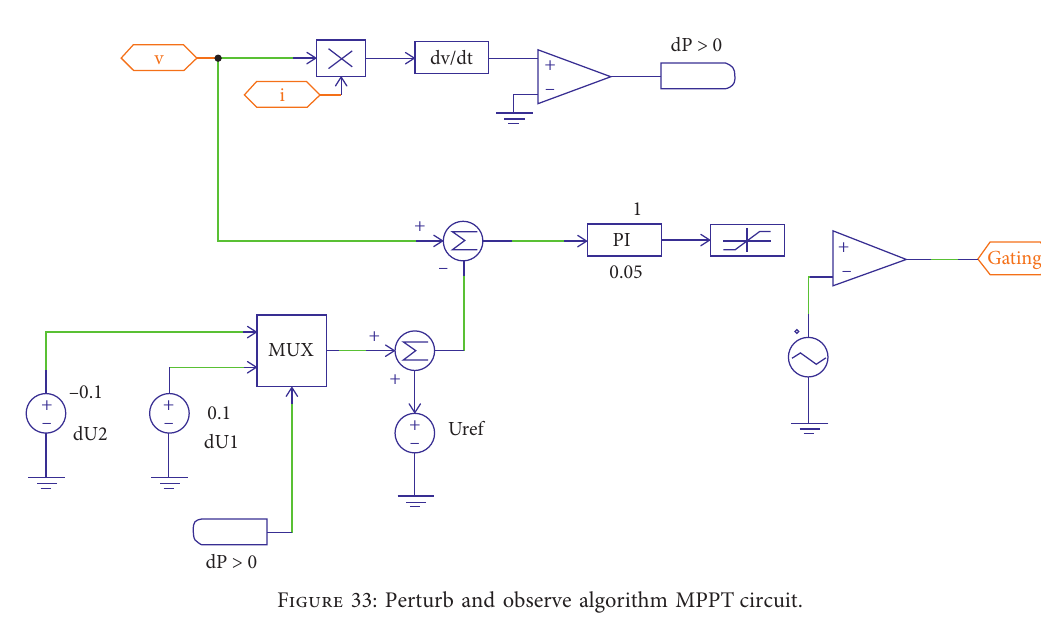
Figure 33: Perturb and observe algorithm MPPT circuit.